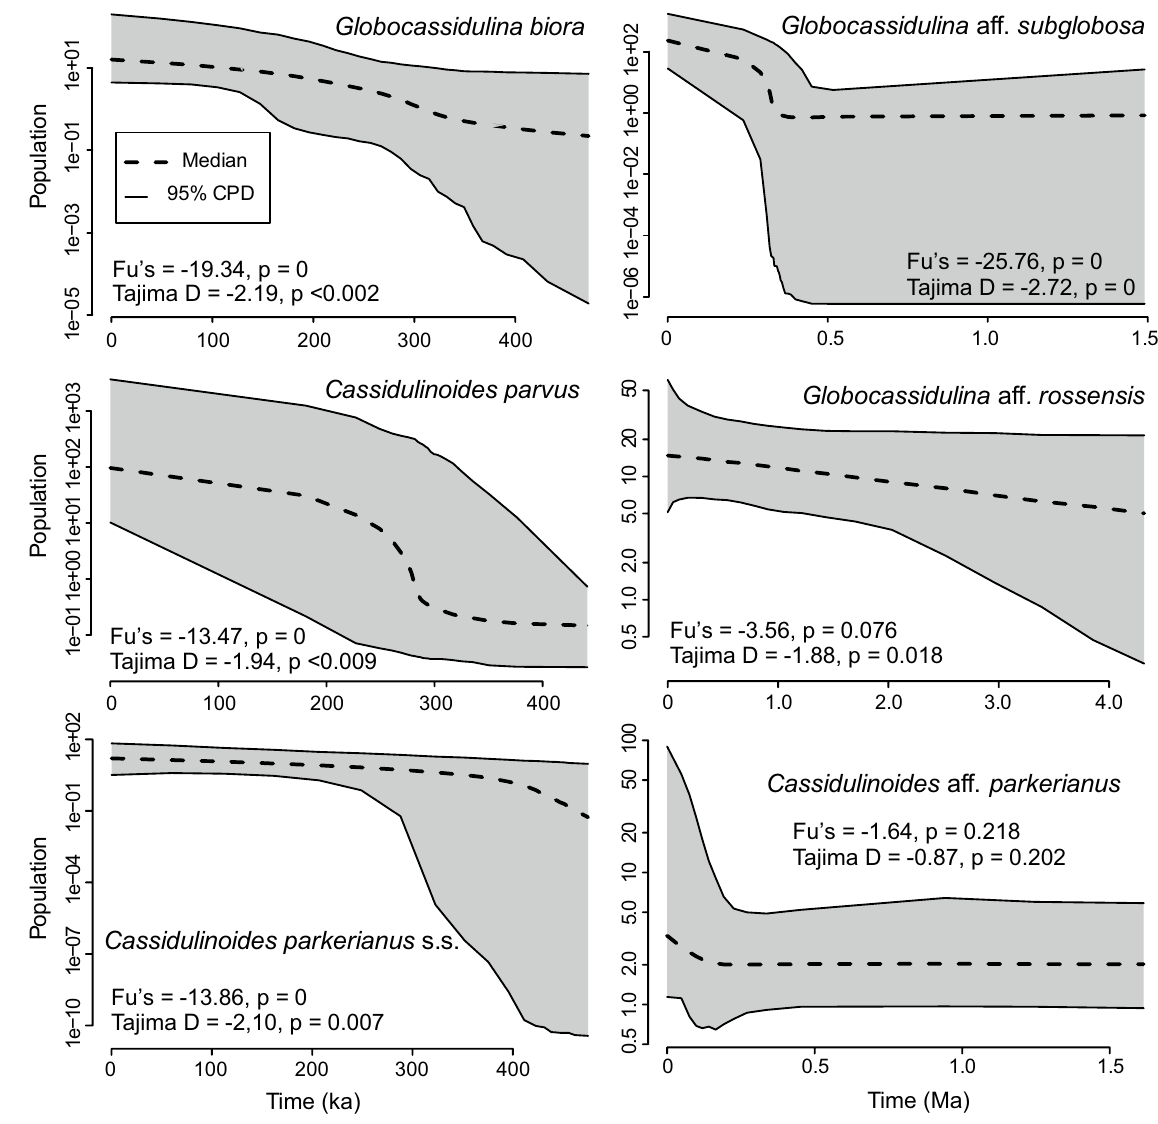
Figure 6. Historical demographic trends of population size constructed using Bayesian skyline plot approach based on SSU rDNA of Antarctic and sub-Antarctic Cassidulinidae. The y-axis (population size) is on a log scale;the x-axis is the time in 10 3 (left column) and 10 6 (right column) years before present. Results of neutrality Tajima’s D and Fu’s Fs tests are indicated in Appendix